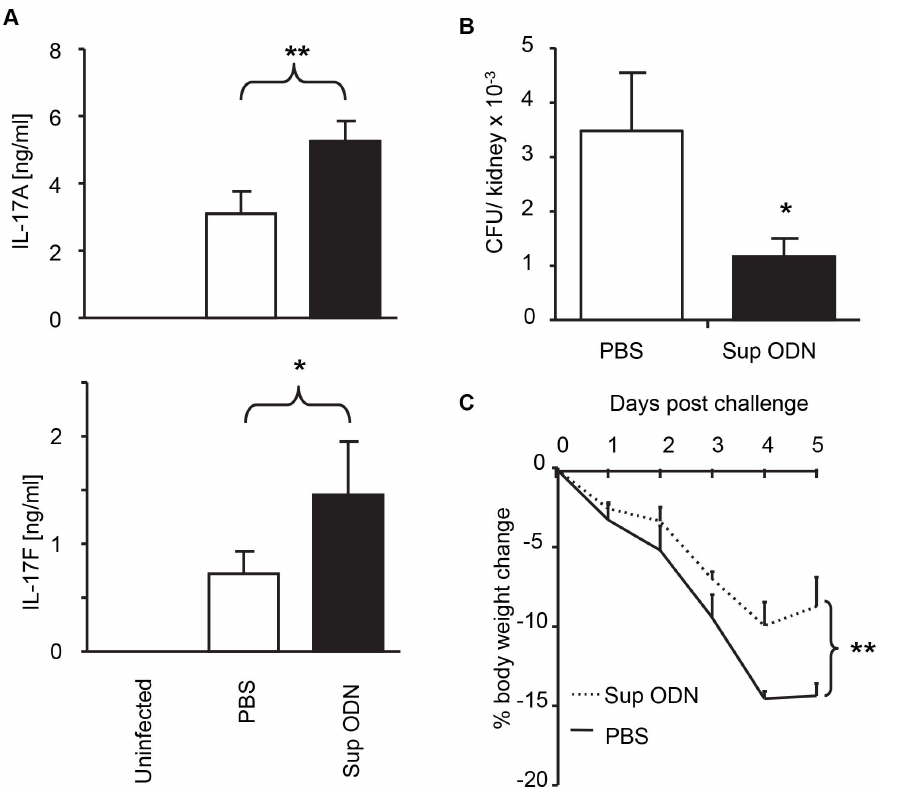
Figure 2. Effect of Suppressive ODN on C.albicans infection of mice. C57BL/6 mice were challenged i.v. with 10 5 CFU of C. albicans. 3 h before and 3 days after challenge these mice were treated i.p. with 300 m g of Sup ODN or PBS. On day 5, the kidneys were removed, homogenized and centrifuged. (A) The supernatant from each kidney was analyzed for the presence of IL-17A and IL-17F while (B) the homogenate was plated to quantify viable Candida . Weight loss was also monitored (C). Data in are representative of three independent experiments involving a total of 15 mice/group. *, p , 0.05. **, p , 0.01 vs PBS. doi:10.1371/journal.pone.0067991.g002 ODN treatment protects mice against inflammatory and autoim- mune diseases [2–4]. Sup ODN are composed of repetitive TTAGGG motifs identical to those found at high frequency in mammalian